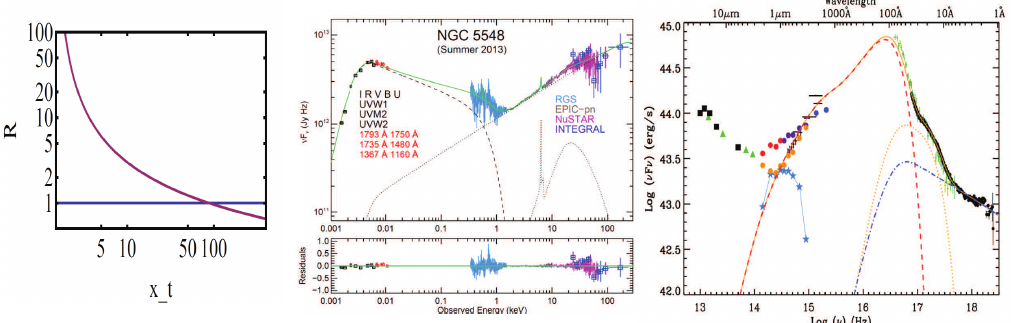
Figure 2. ( Left ) The ratio R of the thermal (BBB) to the X-ray bolometric luminosities as a function of the transition radius x t from the SS73 to the ADAF disk regime. ( Middle ) The ν F ν spectrum of NGC 5548 (from [29]) indicating a slight dominance of the X-ray luminosity, implying for this case that x t > ∼ 100. ( Right ) Same as ( Middle ) but for the NLS1 PG 1124+026 (from [30]); in this case the BBB component is dominant implying x t < ∼